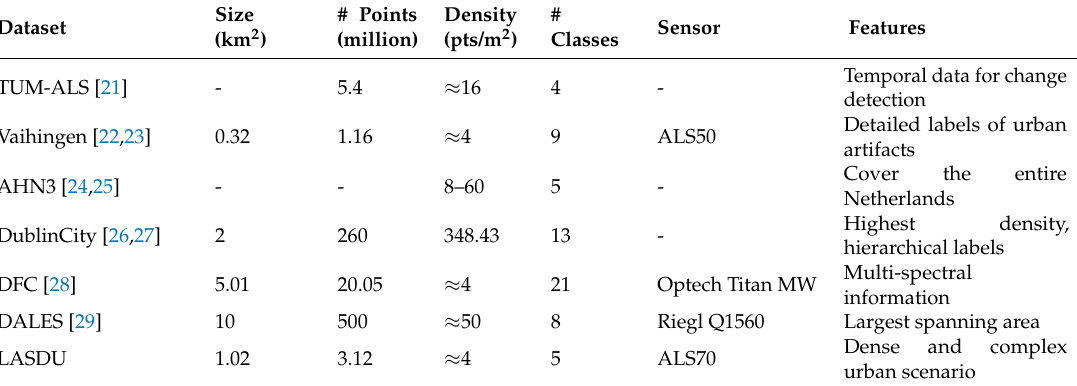
Table 1. Representative ALS point cloud datasets for semantic